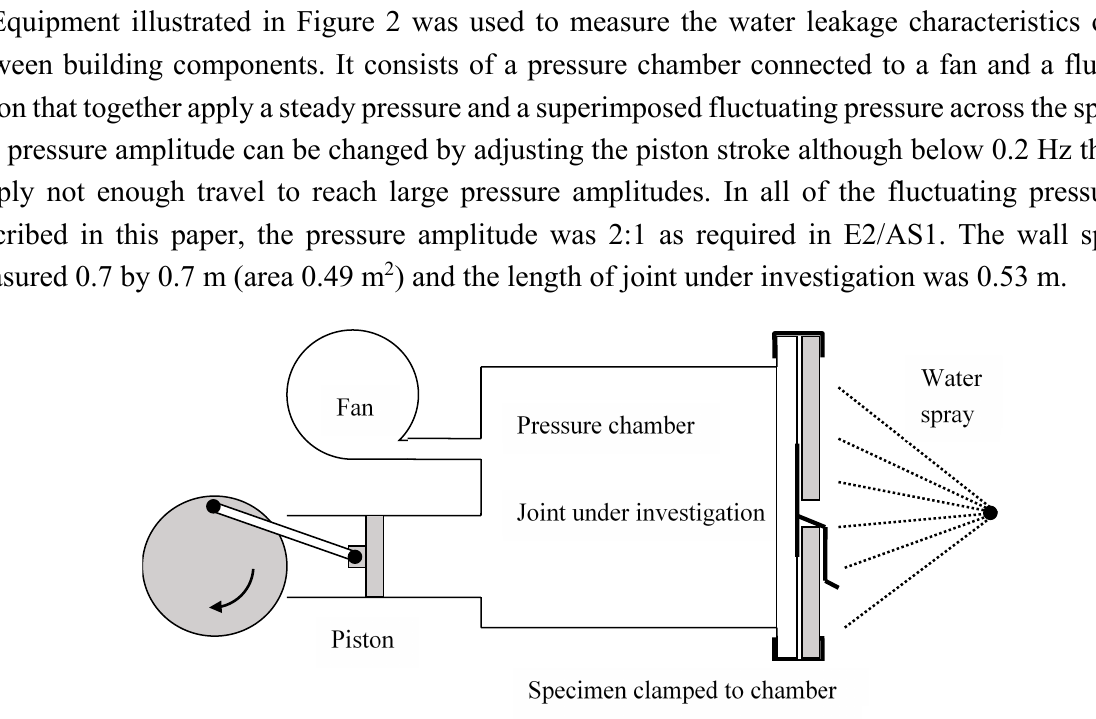
Figure 2. Equipment for measuring the weathertightness characteristics of